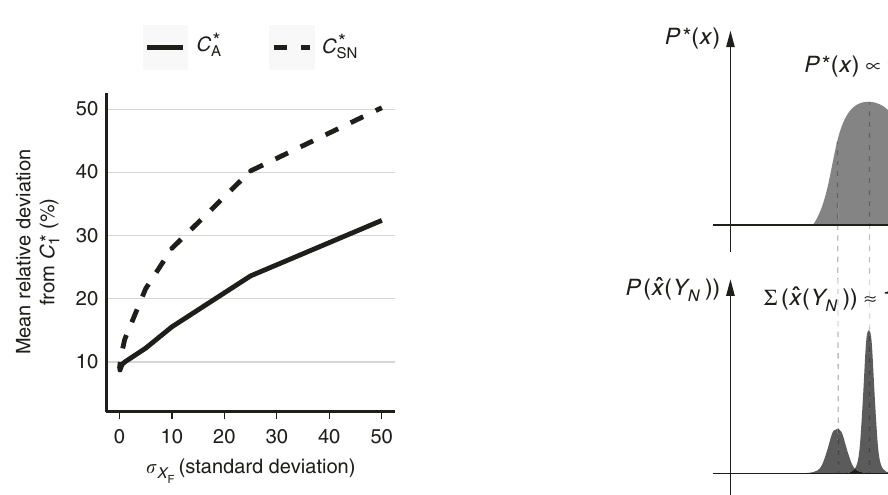
Fig. 1 Asymptotic capacity, C (cid:1) A , does not deviate substantially from non- asymptotic capacity, C (cid:1) , in the test model. Average deviation of C (cid:1) A and C (cid:1) 1 from C (cid:1) calculated based on all 27 considered scenarios of the test model are 1 plotted against the standard deviation of the model noise, σ X computed without approximations using BA algorithm. Scenarios used to calculate the deviations were combinatorially generated by considering different values of L , λ , and non-cognate ligand distributions (see Section 2 of SI).